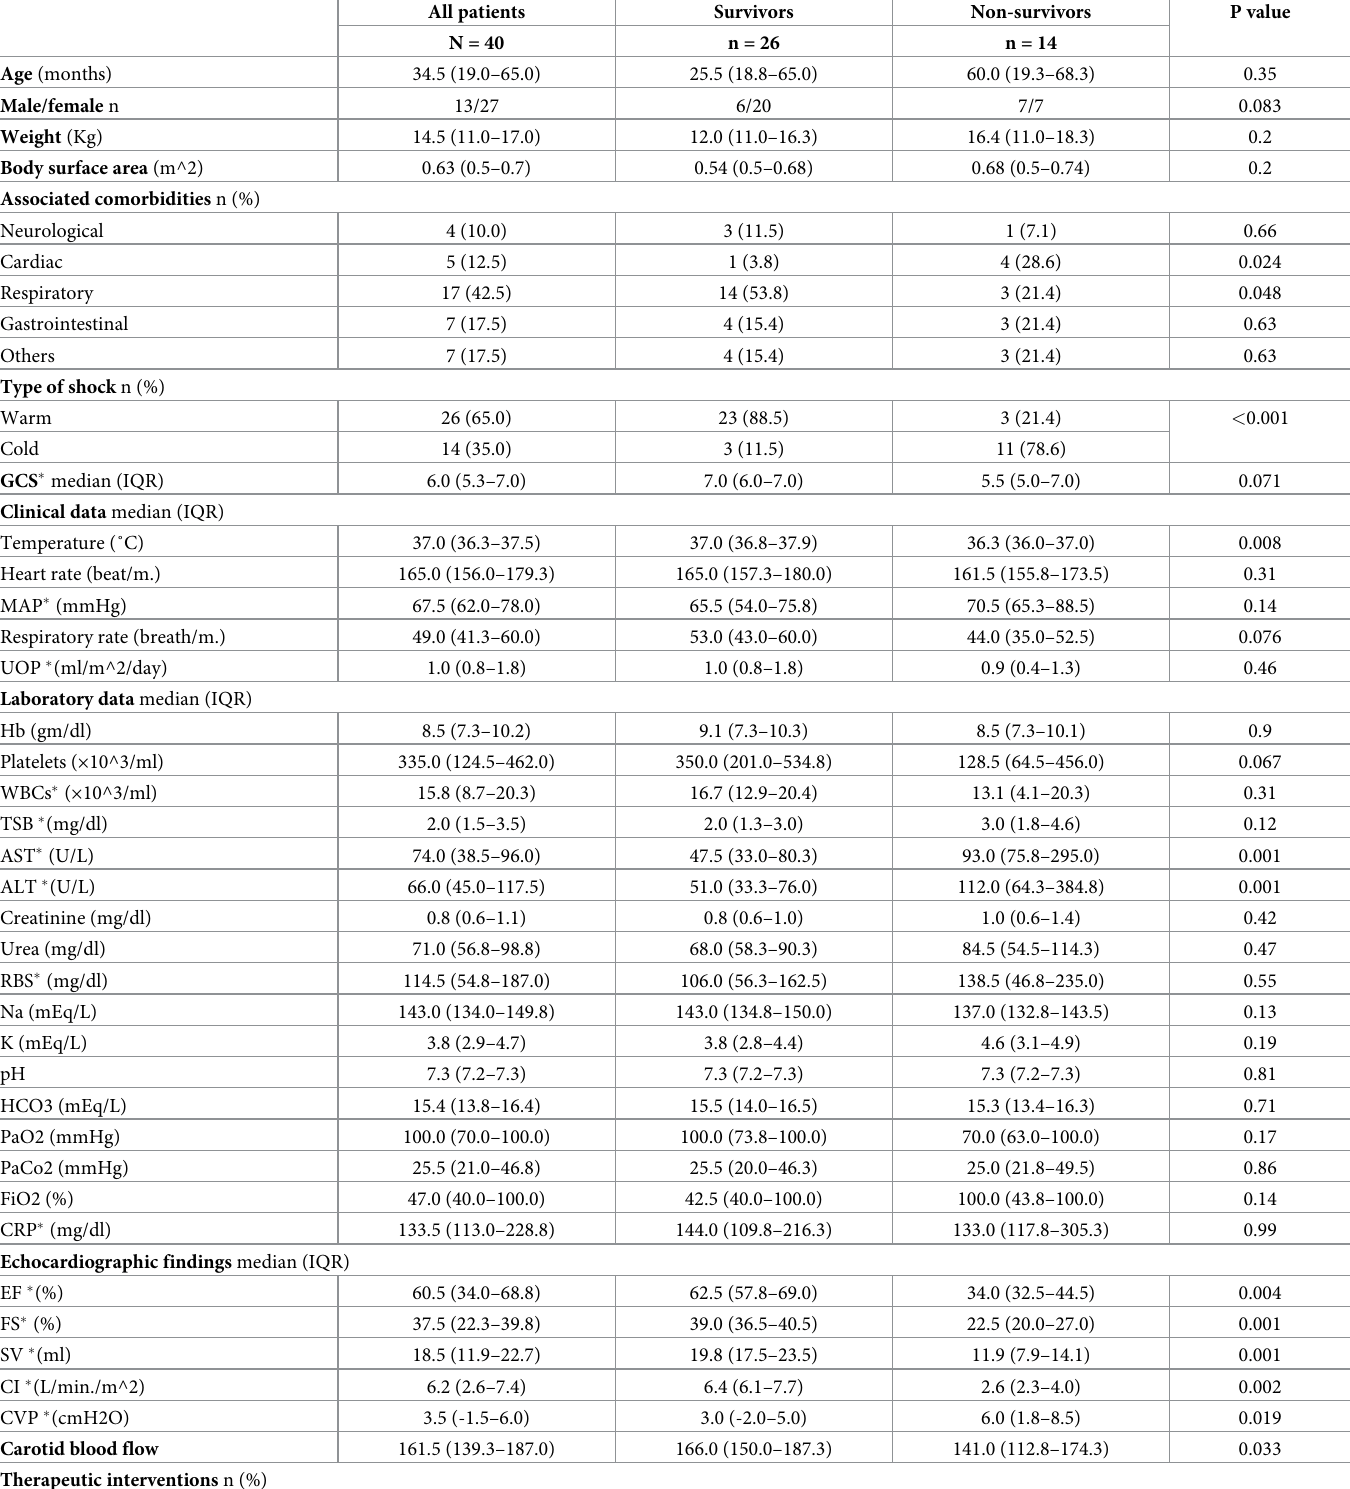
Table 1. Clinical data and therapeutic interventions in the studied patients.